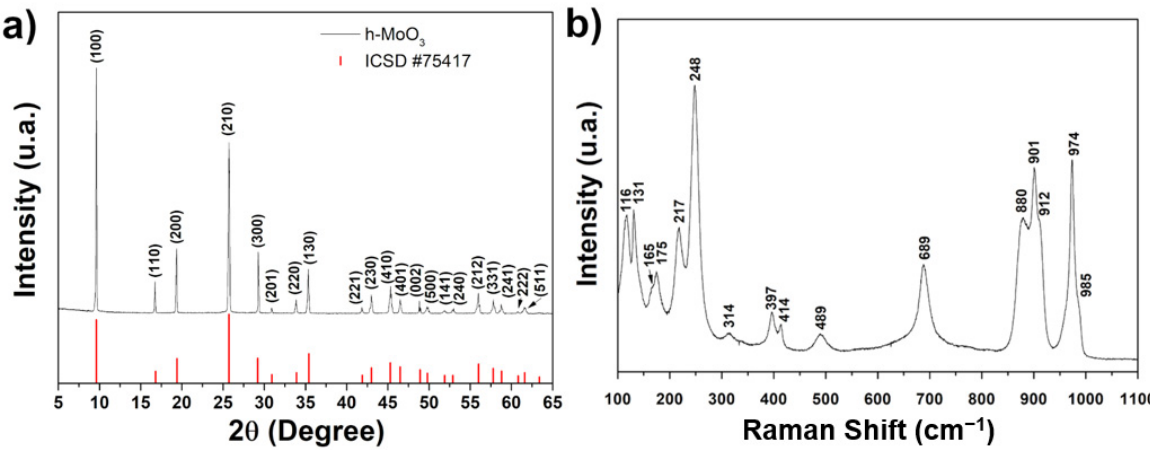
Figure 1. ( a ) XRD pattern and ( b ) Raman spectra of the as-grown h-MoO 3 via MAH method at 125 °C for 1 min.